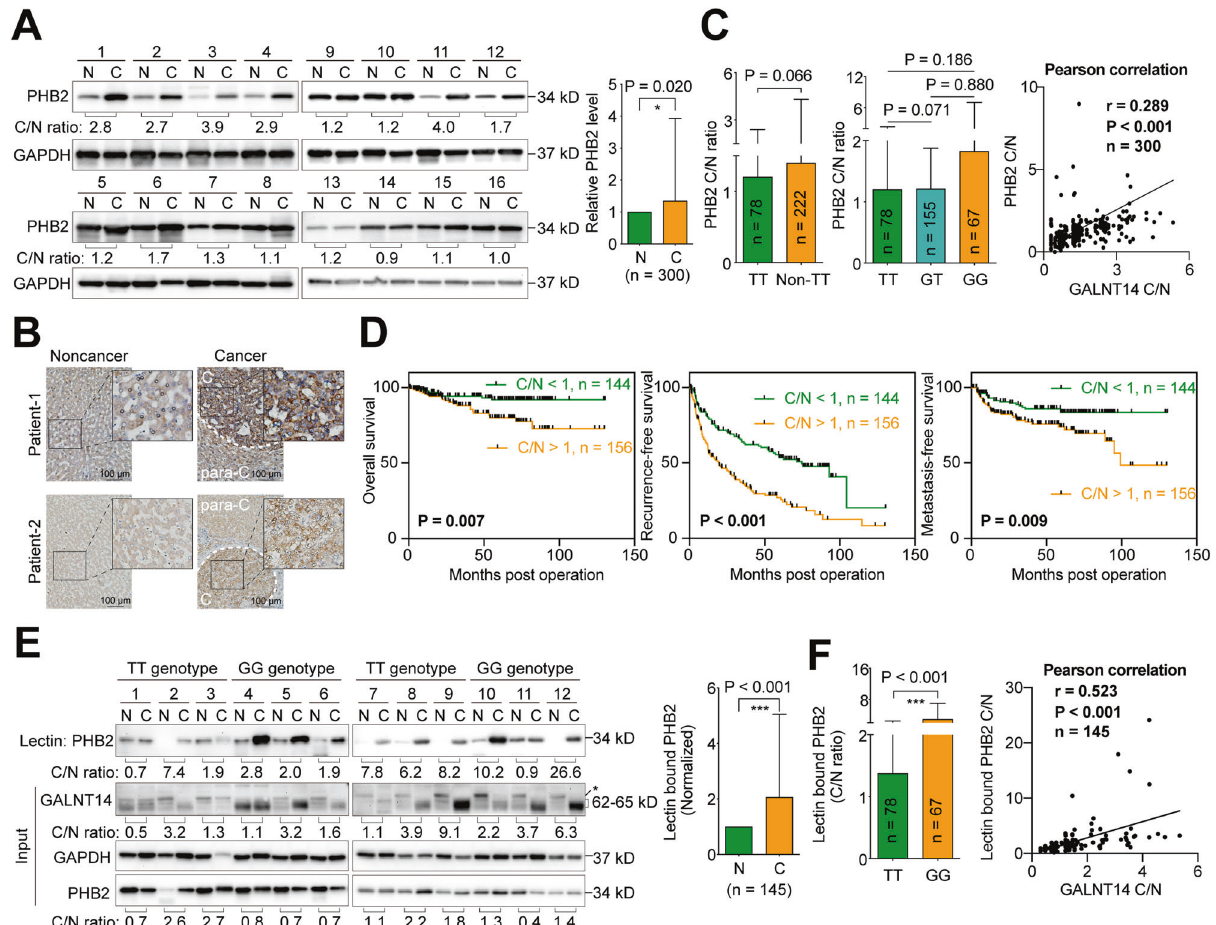
Fig. 6 PHB2 and its O -glycosylated forms are upregulated in HCC. A Representative images of western blots of HCC patient samples. N noncancerous part, C cancerous part. Statistical comparison between PHB2 levels in the noncancerous and cancerous parts is given in the right panel. P values were calculated by paired two-tailed student ’ s t test. B Representative IHC images of HCC patient tissues. The scale bar is given in the right lower corner. C cancerous tissue, para-C para-cancerous tissue. C Statistical comparison of PHB2 cancerous/noncancerous (C/ N) ratios between tissues from patients with the indicated rs9679162 genotypes (left and middle panel). P values were calculated by the two- tailed Mann – Whitney U test. The C/N ratios of GALNT14 protein and PHB2 protein were correlated using the Pearson correlation (right panel). D Kaplan – Meier analysis of overall (left), recurrence-free (middle), and metastasis-free (right) survival, strati fi ed by the C/N ratio of PHB2 protein. P values were calculated by log-rank test. E Representative image of western blots of samples of lectin pulldown assays using lysates extracted from HCC tissues (upper panel). A statistical comparison of PHB2 protein levels between the noncancerous (N) and cancerous (C) tissues is given in the right panel. P value was calculated by paired two-tailed student ’ s t test. F Statistical comparison of the C/N ratio of lectin- bound PHB2 in HCC tissues between patients with the indicated rs9679162 genotype (left panel). The C/N ratios of GALNT14 protein and lectin-bound PHB2 protein were correlated using the Pearson correlation (right panel). TT rs9679162-TT genotype, Non-TT rs9679162-non-TT genotype, GT rs9679162-GT genotype, GG rs9679162-GG